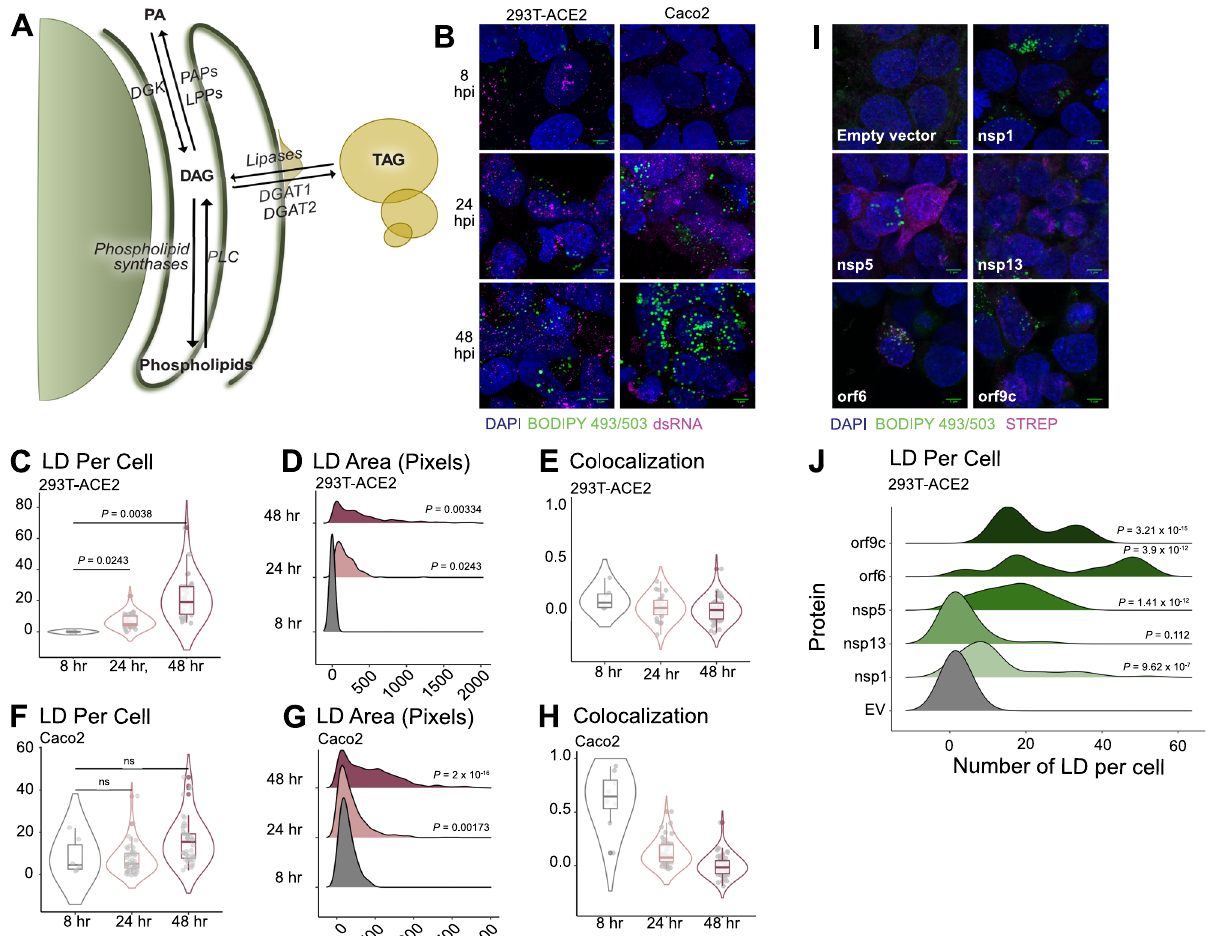
Fig. 4 Lipid droplets are induced following SARS-CoV-2 infection and after the transfection of key viral proteins. A Overview of central glycerolipid metabolism. PA = phosphatidic acid; PAP = phosphatidic acid phosphatase; LPP = lysophosphatidic acid phosphatase; DGK: diacylglycerol